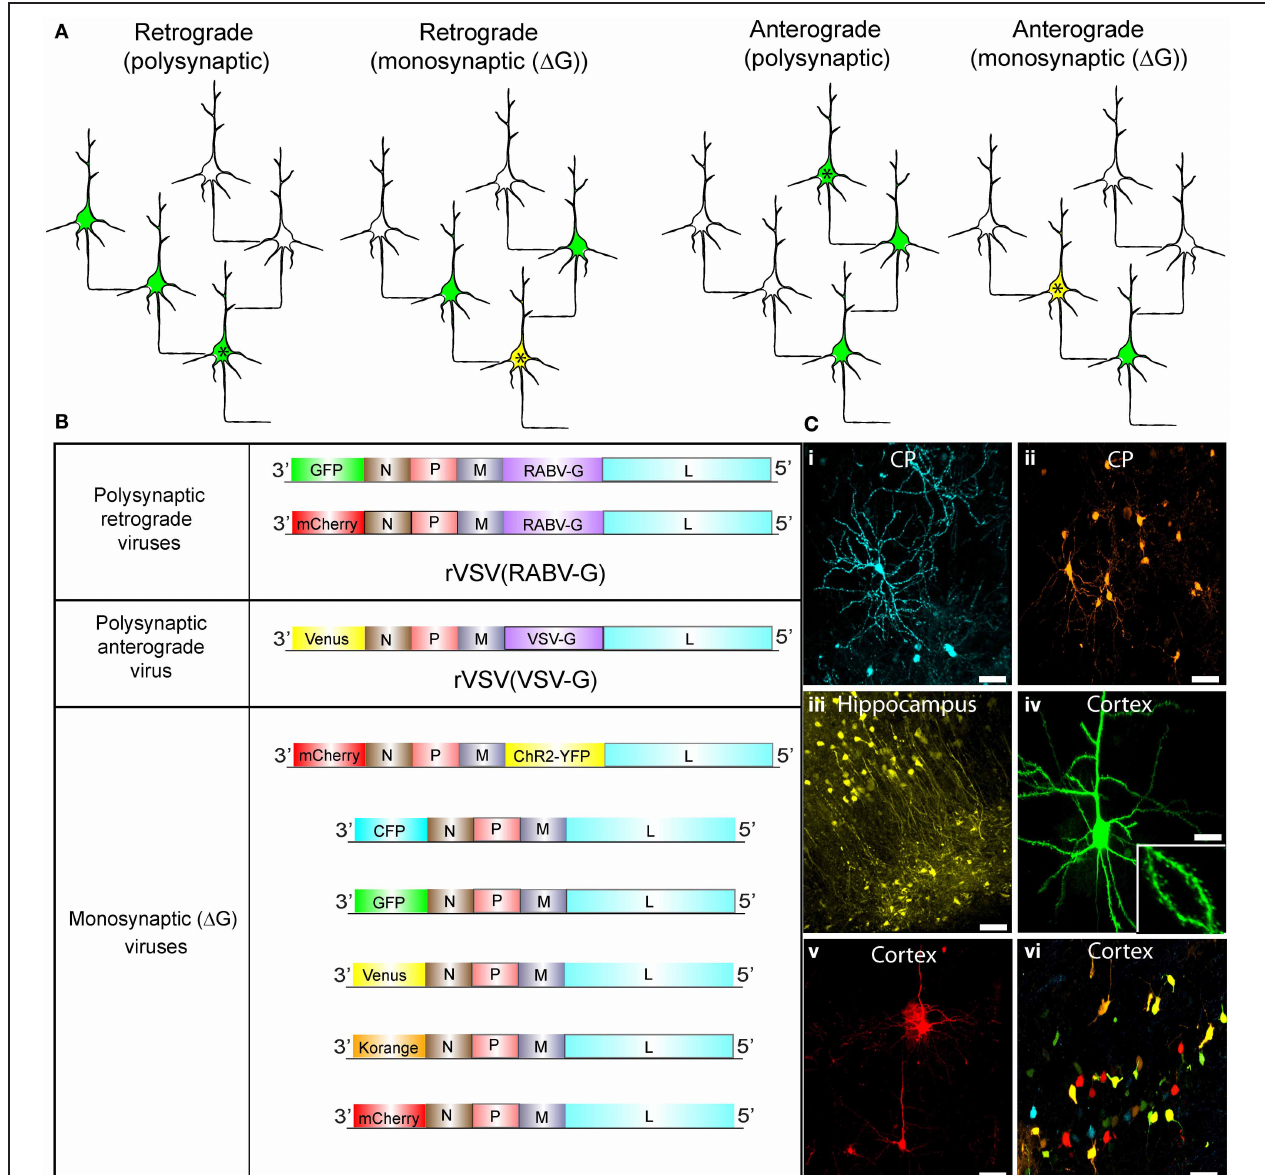
FIGURE 1 | Synaptic tracing strategies using VSV. (A) Schematic illustrating the strategies for polysynaptic or monosynaptic retrograde or anterograde transsynaptic transmission of rVSV encoding GFP. The initially infected cell is indicated by an asterisk. VSV encoding a glycoprotein (G) within its genome can spread polysynaptically. The direction of the spread depends on the identity of the glycoprotein. Infected neurons are shown in green. In some cases, the initially infected starter cell can be defined by the expression of an avian receptor, TVA (tagged with a red fluorescent protein). The TVA-expressing neurons can then be specifically infected by rVSV (cid:2) G with the EnvA/RABV-G (A/RG) glycoprotein (Wickersham et al., 2007b) on the virion surface [rVSV (cid:2) G(A/RG)]. These starter cells are then yellow, due to viral GFP and mCherry from TVA-mCherry expression. For monosynaptic tracing, the G protein is expressed in trans in the TVA-expressing cell, and thus complements rVSV (cid:2) G to allow transmission in a specific direction. (B) Genomic diagrams of rVSV vectors. All VSVs contain four essential proteins: N, P,